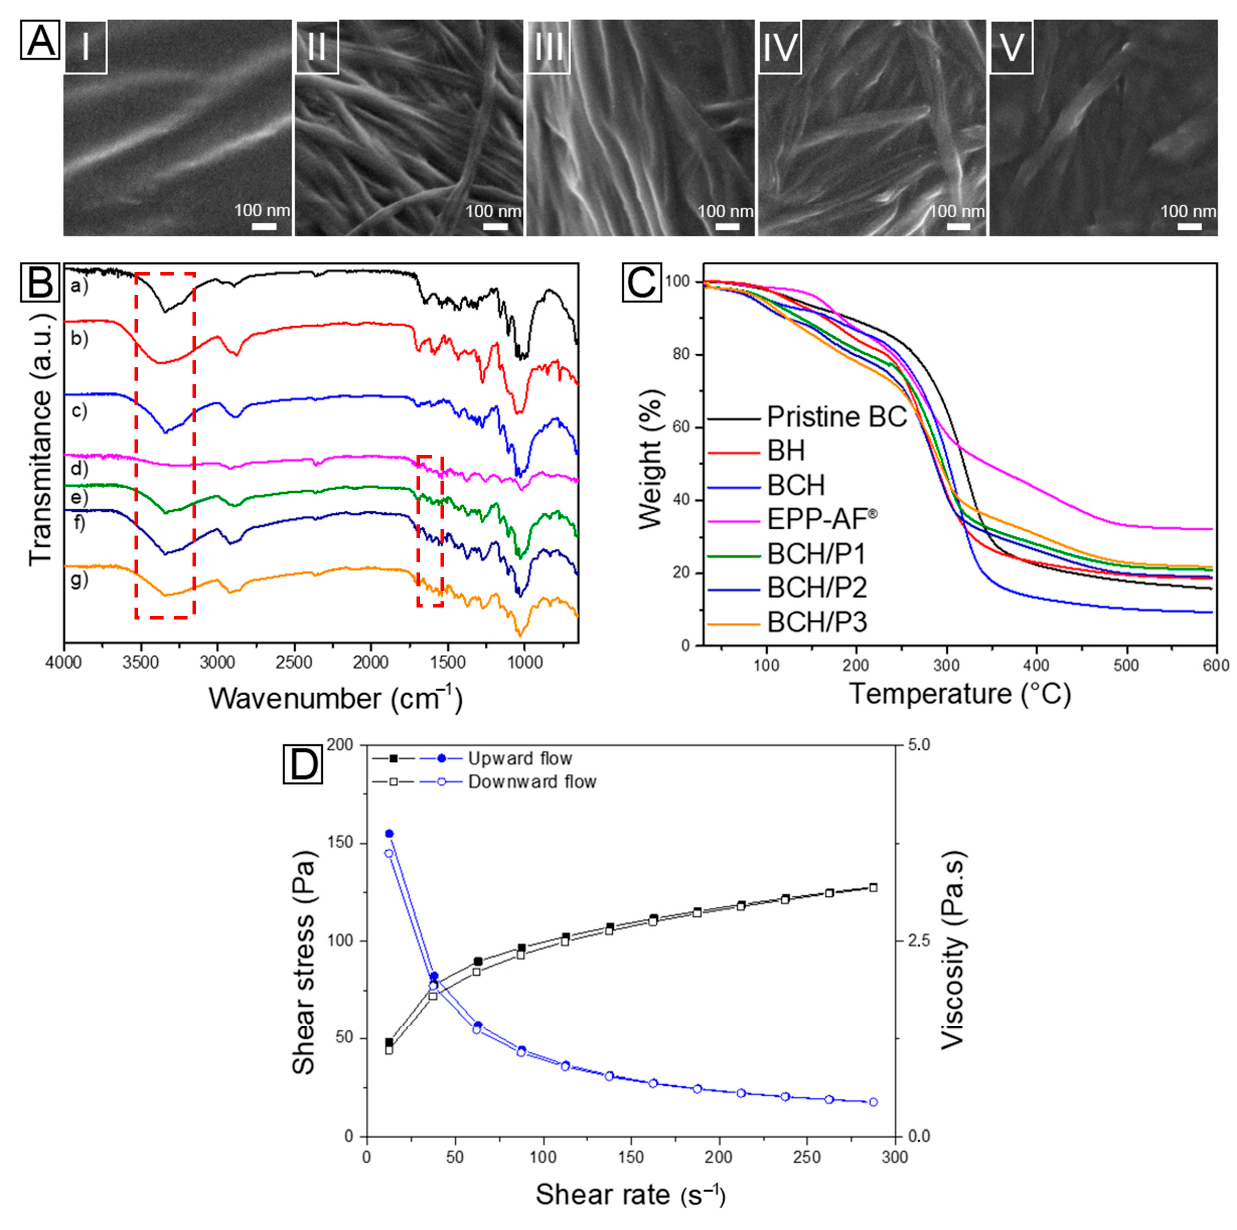
Figure 1. ( A ) SEM images of ( I ) BH, ( II ) BNCH, ( III ) BNCH/P1, ( IV ) BNCH/P2, and ( V ) BNCH/P3. ( B ) FTIR spectra of ( a ) pristine BNC, ( b ) BH, ( c ) BNCH, ( d ) EPP-AF ® , ( e ) BNCH/P1, ( f ) BNCH/P2, and ( g ) BNCH/P3. ( C ) TGA curves. ( D ) Flow curve of a representative BNC-based hydrogel.